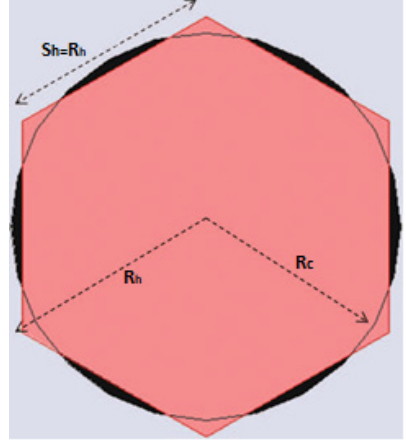
Figure 5. Hexagonal antenna geometry.